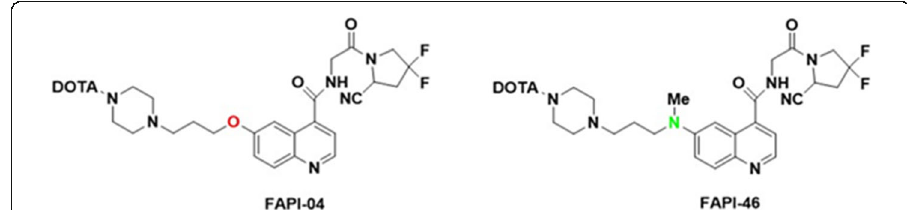
Fig. 1 Molecular Structures of FAPI-04 and FAPI-46